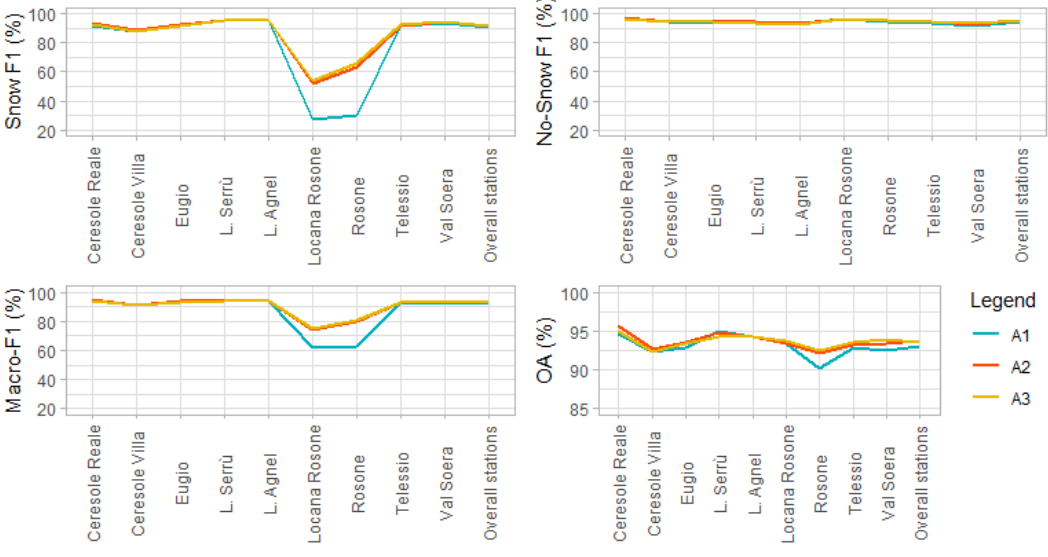
Figure 9 . Accuracy metrics for Snow and No-Snow classes of the classification’s performances against weather stations. F1 = F1-score, OA = Overall Accuracy. A1 = blue line, A2 = red line, A3 = yellow line.